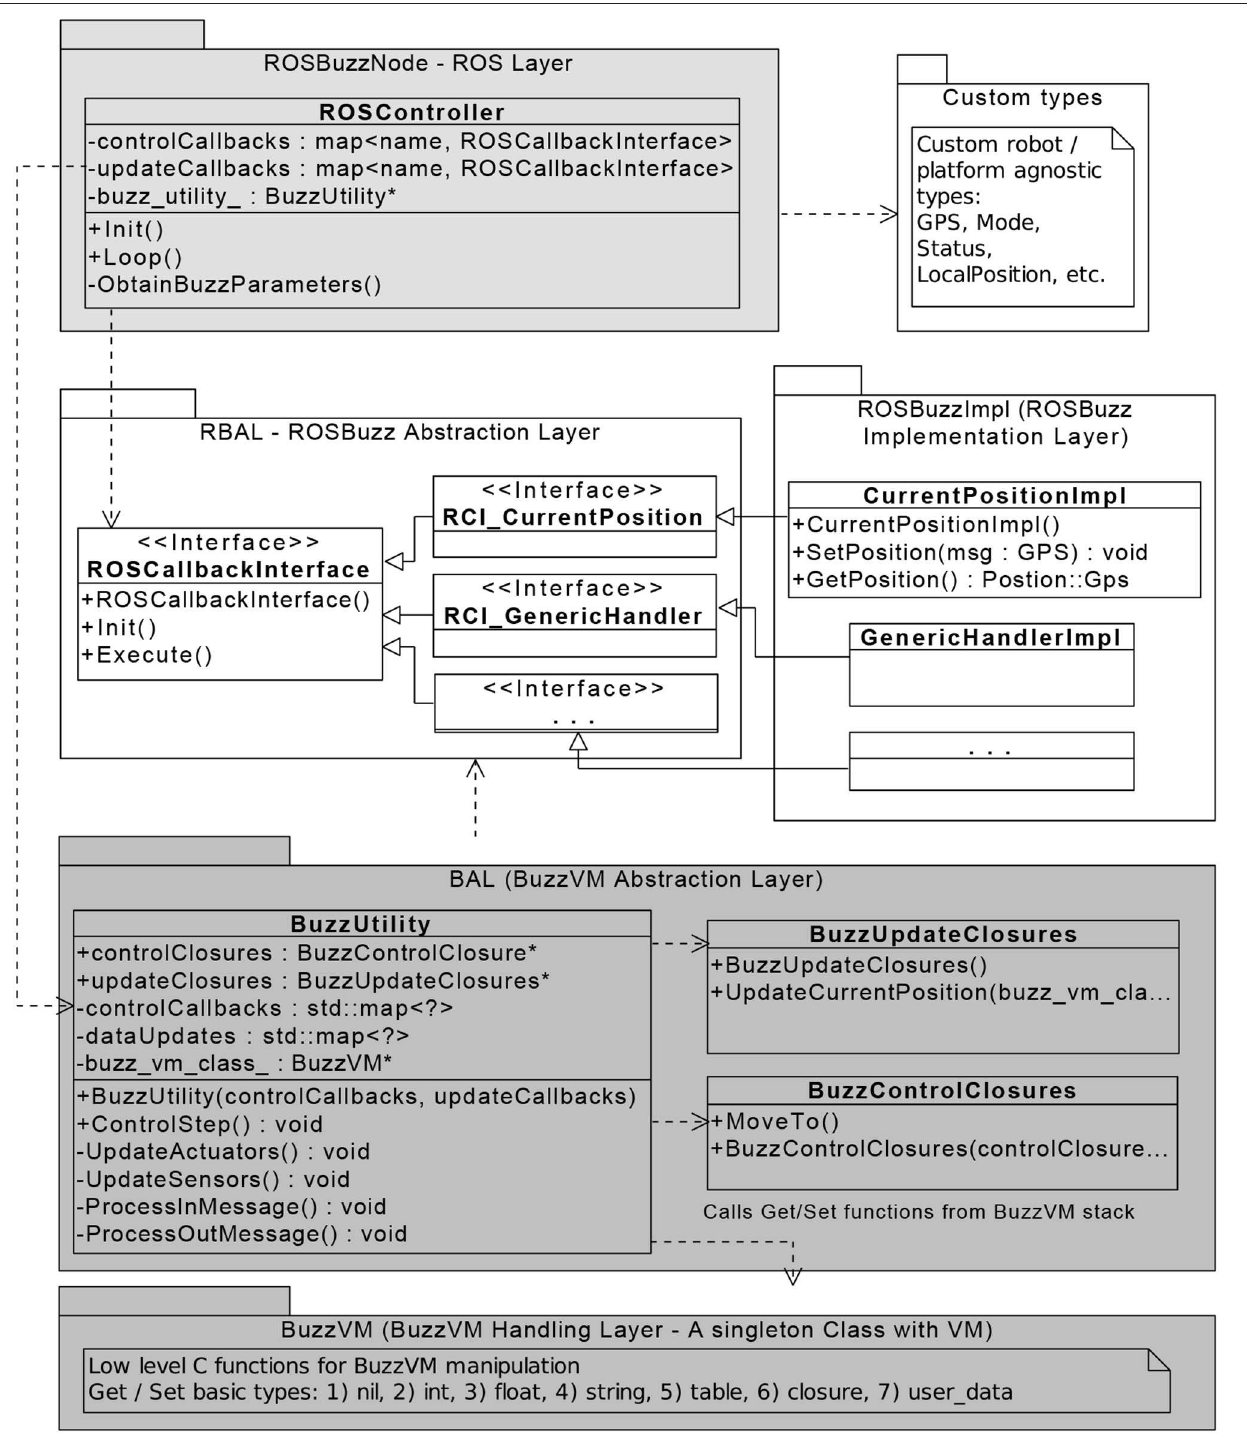
FIGURE 2 | Relationship between classes of the internal ROSBuzz software